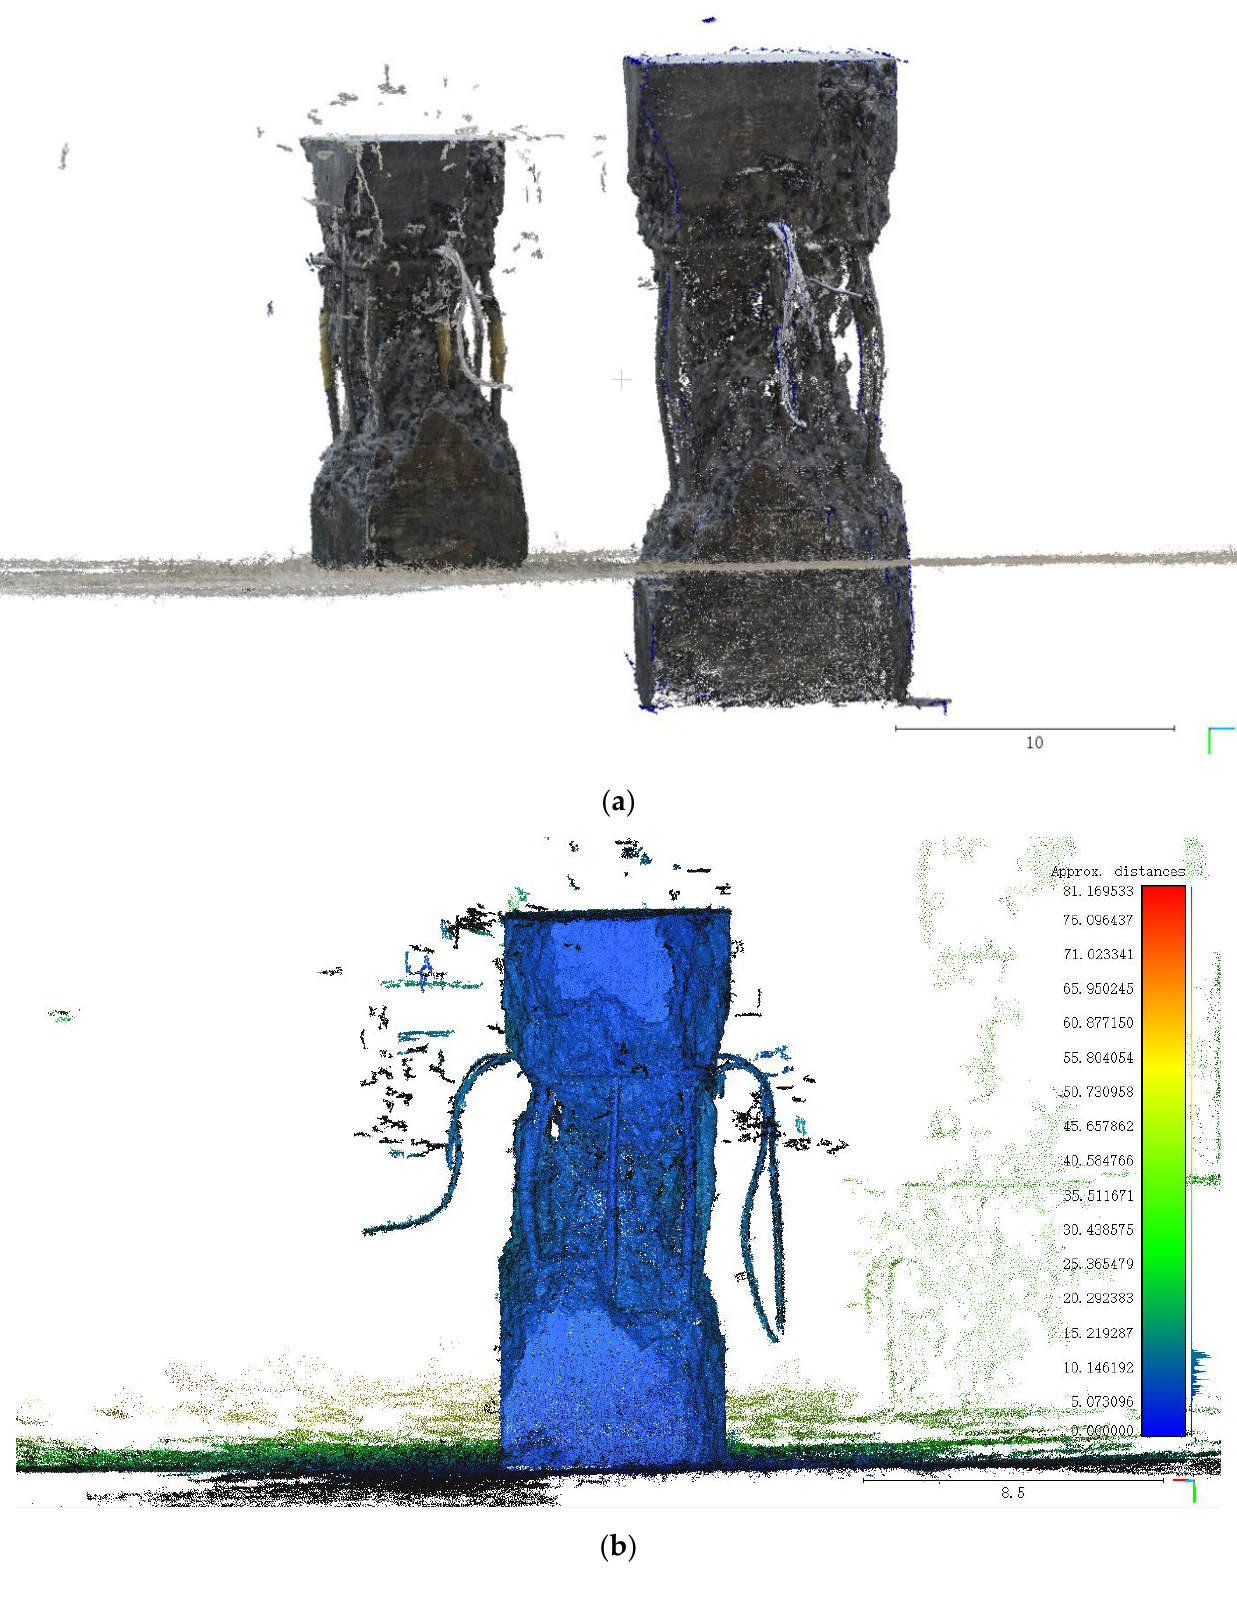
Figure 8. The results of the alignment between the 3D models of the original image and the segmented image. ( a ) The two models before alignment; ( b ) The two models after